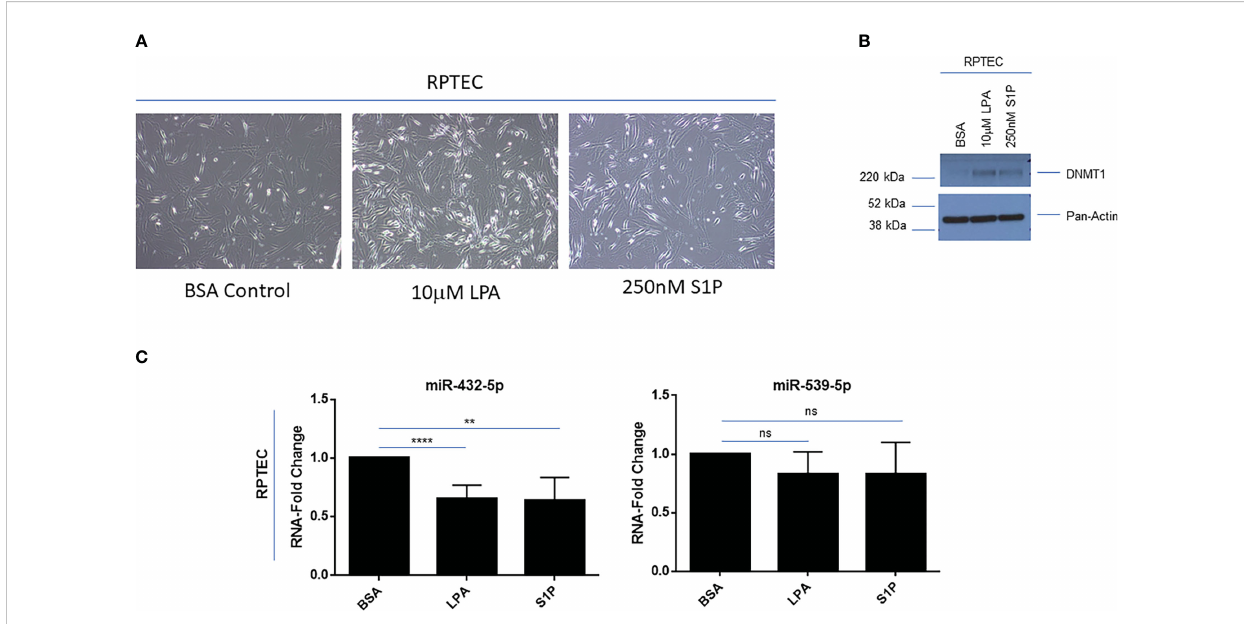
FIGURE 6 Lysophosphatidic acid (LPA) and sphingosine-1-phosphate (S1P) modulate 14q32 miRNA expression in primary RPTECs. (A) Light microscopic images of RPTEC cells treated with BSA, LPA, or S1P captured at 20x magni fi cation. (B) Protein lysates were obtained from BSA, LPA, or S1P treated RPTEC cells followed by western blotting using the antibodies shown. (C) qPCR analyses of miR-432-5p and miR-539-5p (normalized to RNU48 ) in RPTEC in response to treatment with BSA (control), LPA, or S1P. The composite of three independent experiments is shown. ns, not signi fi cant; ** p -values ≤ 0.01; **** p -values ≤